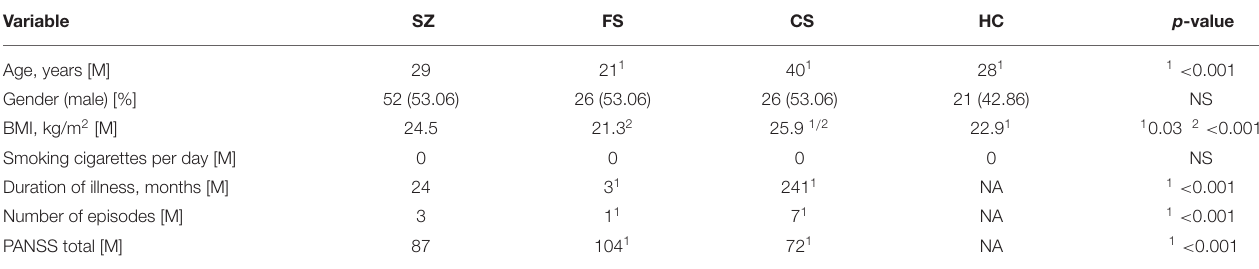
TABLE 1 | Characteristic of examined population. Variable